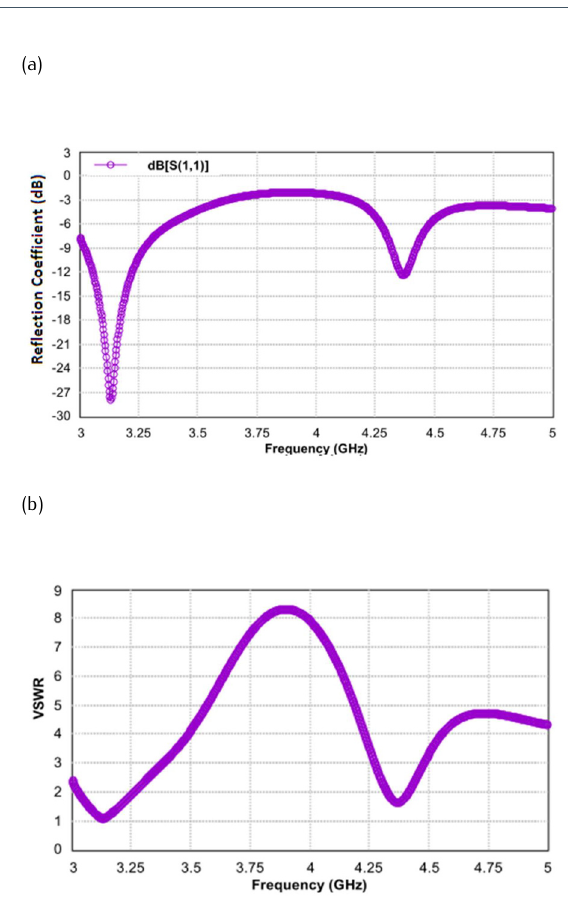
Figure 4. (a) Variation of simulated reflection coefficient ( S of stacked geometry without airgap with respect to frequency; (b) Simulated VSWR of stacked geometry without air gap as a function of